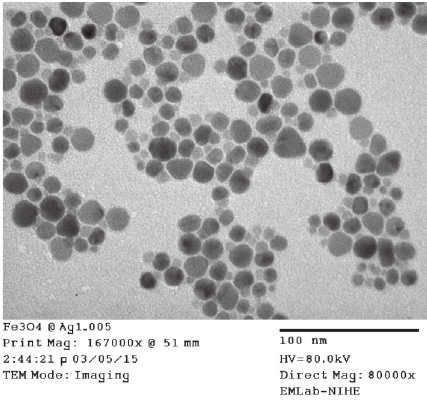
Figure 3: TEM image of Fe 3 O 4 –Ag hybrid nanoparticles dispersed in